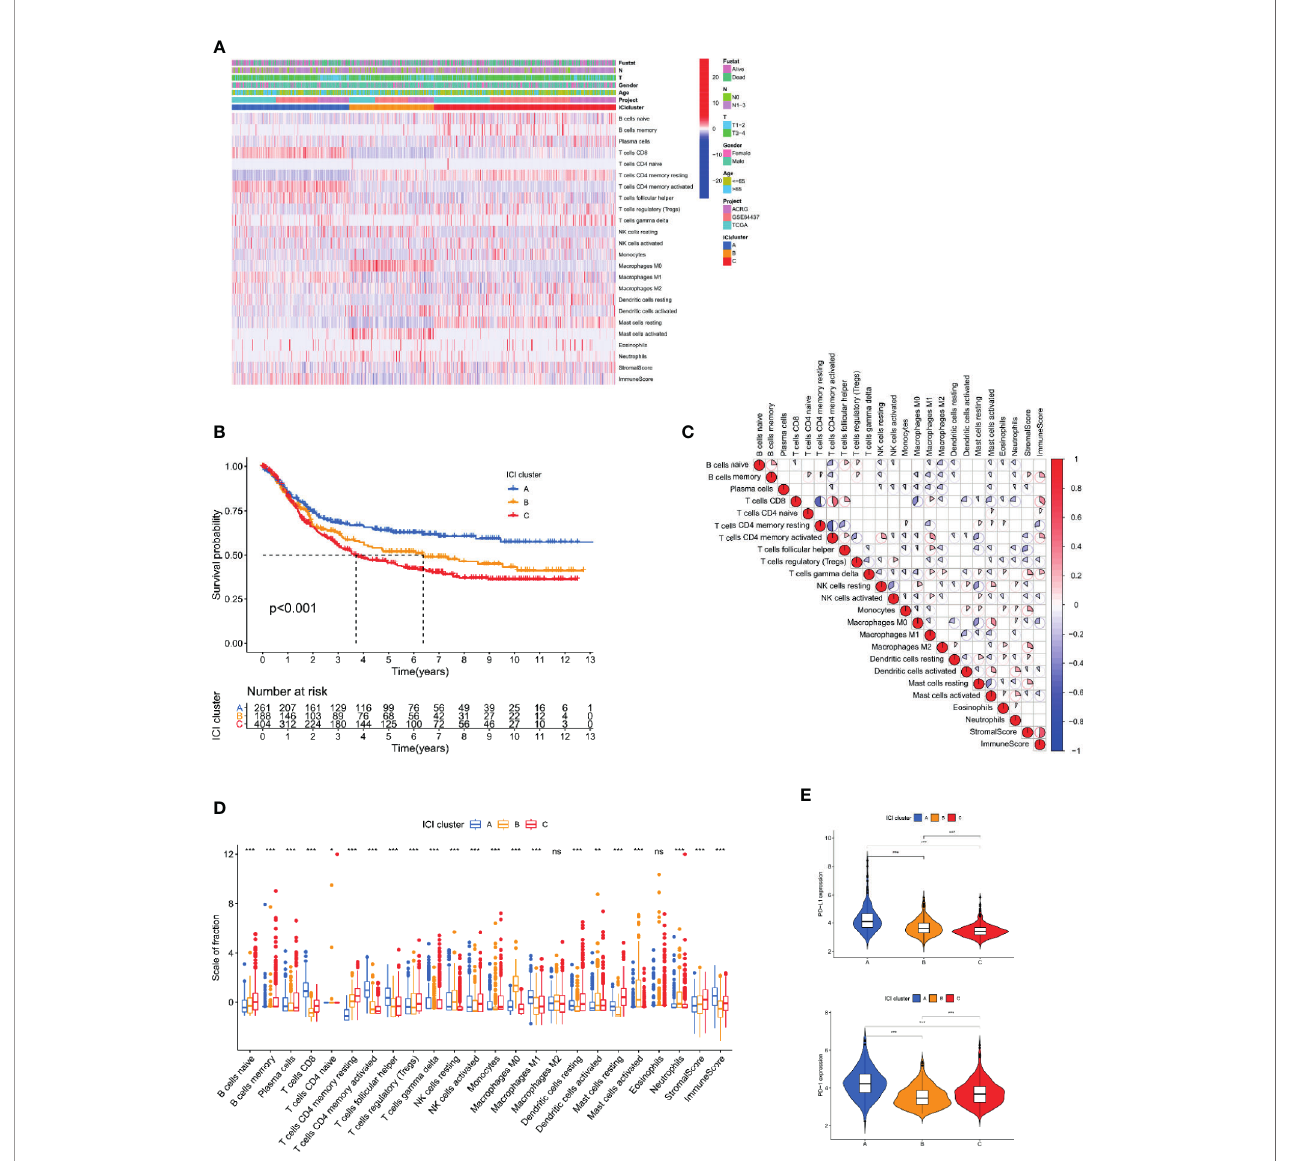
FIGURE 1 | The spectrum of in fi ltrative immune cells in the tumor microenvironment of GC. (A) Unsupervised clustering of 22 immune cells derived from CIBERSORT algorithm in 3 GC datasets. The patients were divided into 3 cohorts based on the spectrum of in fi ltrative immune cells. (B) Log rank test shown by Kaplan-Meier curves indicated a signi fi cant overall survival difference between the different immune cell-in fi ltrating (ICI) classes, p <0.001. (C) The correlations between 22 immune cells derived from CIBERSORT algorithm. (D) The fraction variations of tumor-in fi ltrating immune cells in three ICI clusters. Immune score and stromal score of three ICI clusters based on the ESTIMATE algorithm were also compared. (Kruskal-Wallis test. *p < 0.05; **p < 0.01; ***p < 0.001; ns, not signi fi cantly different). (E) Expression variations of PD-L1 and PD1 among different ICI cohorts (Kruskal-Wallis test, *p < 0.05; **p < 0.01; ***p < 0.001; ns, not signi fi cantly